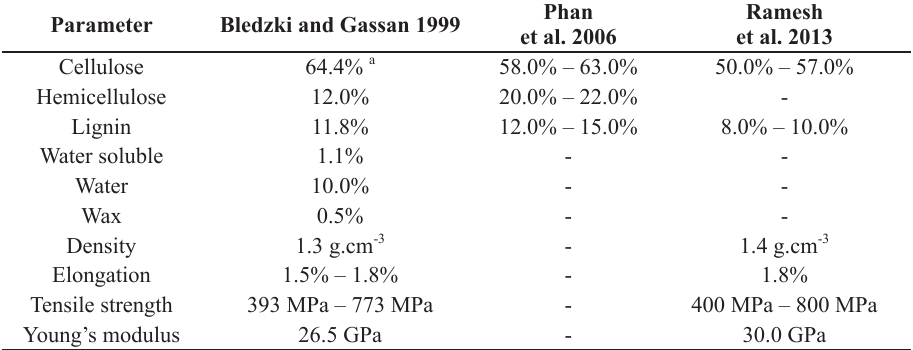
Characterization of in natura jute fiber (Bledzki and Gassan 1999, Phan et al. 2006, Ramesh et al.